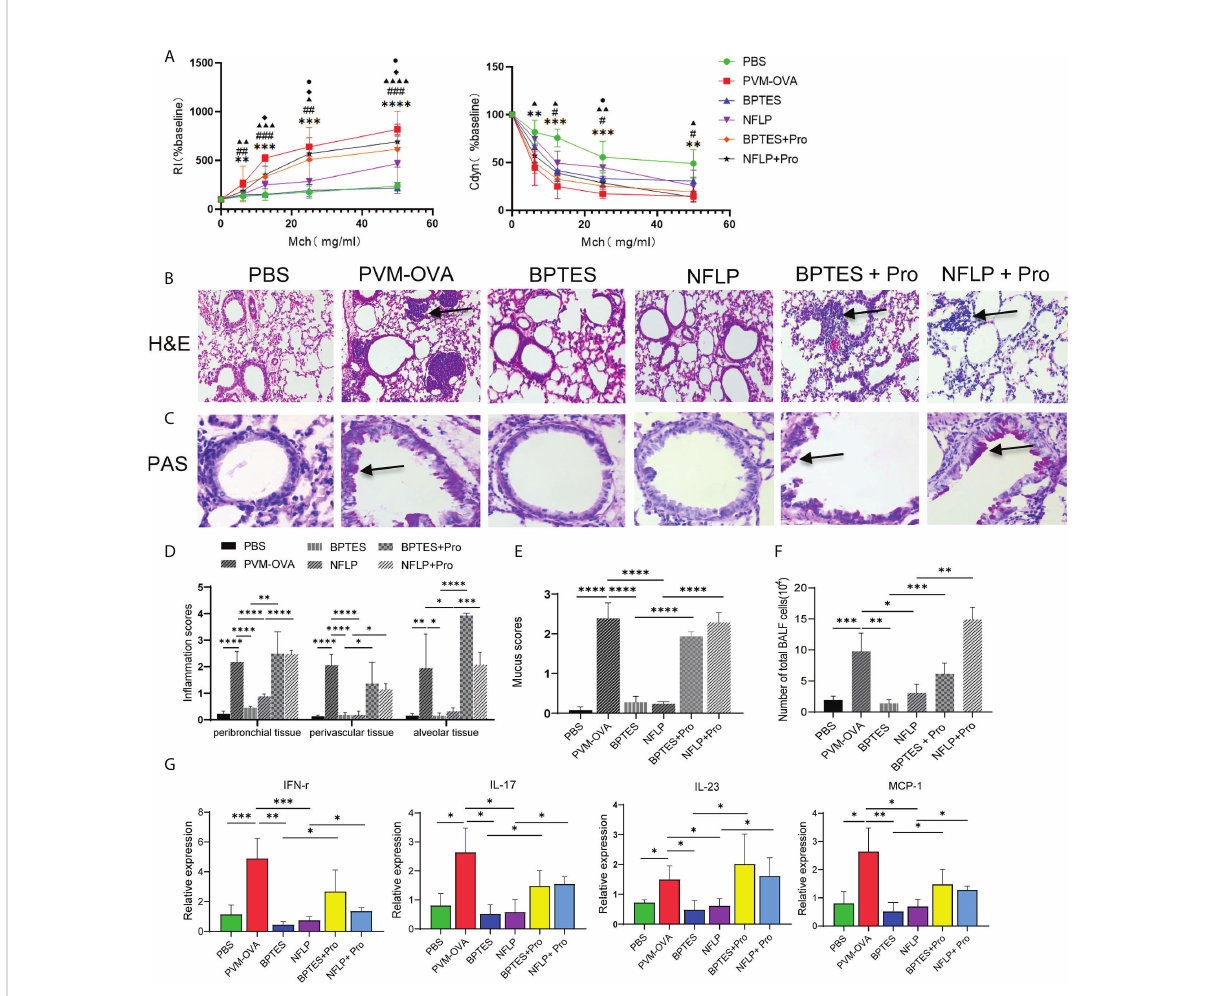
FIGURE 6 Excessive proline synthesis caused by early respiratory virus infection combined with allergen sensitization contributed to allergic asthma in childhood. Mice were sensitized with PVM-OVA, PVM-OVA followed by BPTES or NFLP, or PVM-OVA followed by BPTES+Proline or NFLP +Proline, and challenged with OVA after 21 days post infection. (A) RI and Cdyn to methacholine (MCh, 6.25, 12.5, 25, and 50 mg/ml), (#, ▲ , ◆ P < 0.05, * *,##, ▲▲ P < 0.01, * * *,###, ▲▲▲ P < 0.001. PVM-OVA group compared to PBS group, *, or BPTES group, #, or NFLP group, ▲ . BPTES group compared to BPTES +Pro group, ◆ . NFLP group compared to NFLP +Pro group, ● ). (B) H&E staining shows peribronchiolar, perivascular, and interstitial in fl ammatory cell in fi ltration. (100 X). (C) PAS staining shows bronchiolar mucus production (400X). (D, E) Scores for pulmonary in fl ammation or mucus. (F) Number of in fl ammatory cells in BALF. (G) Relative expression of IFN- g , IL-17, IL-23 and MCP-1 by real- time PCR. Each experimental group contained three biology repeats. Data are presented as means standard deviations of fi ve mice per group and are representative of two experiments. *P<0.05, **P<0.01, ***P<0.001, ****P<0.0001. ▲▲▲▲ means PVM-OVA group compared with NFLP group